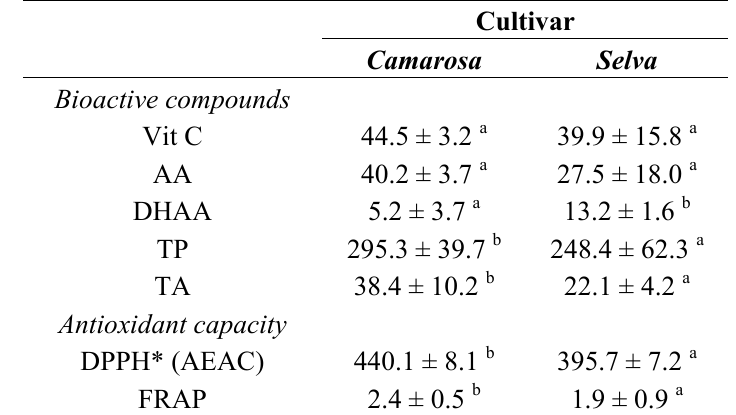
Table 1. Vitamin C (Vit C), ascorbic acid (AA), dehydroascorbic acid (DHAA), total phenolics (TP), total anthocyanins (TA), and in vitro antioxidant capacity (DPPH* and FRAP) in two strawberry